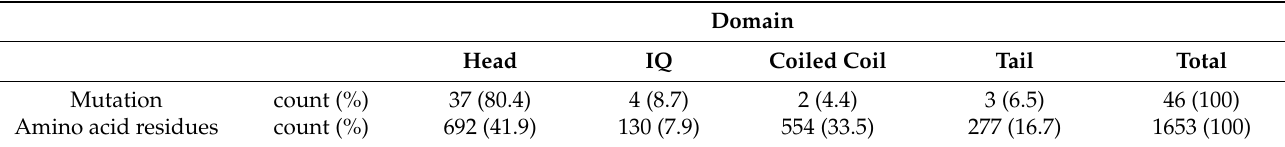
Table 2. MYO5B missense mutation per domain distribution.